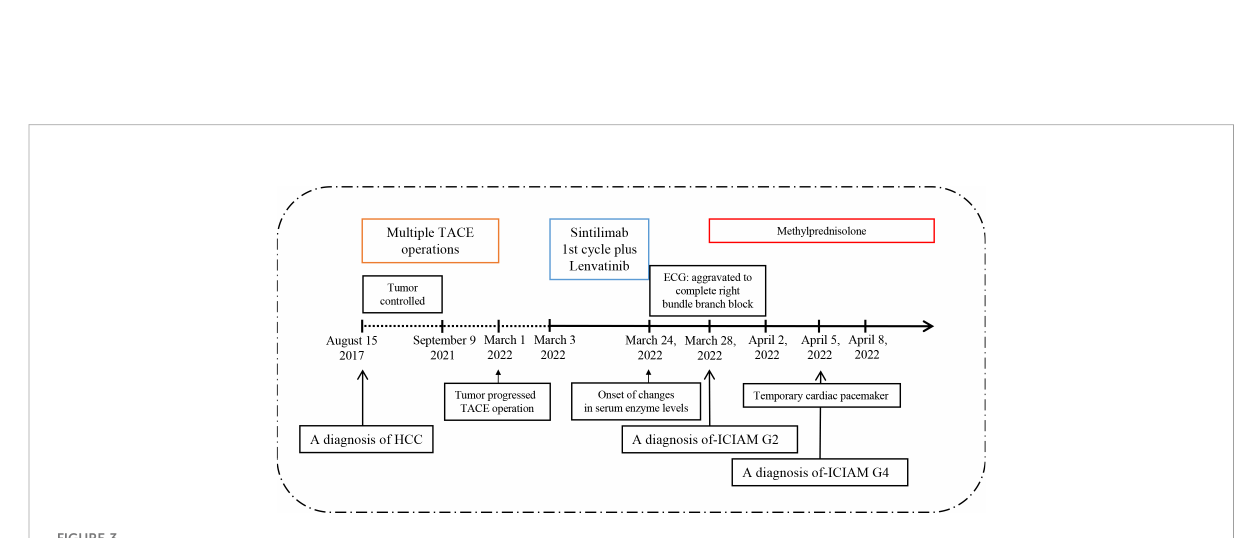
FIGURE 3 Timeline of disease diagnosis and treatment.